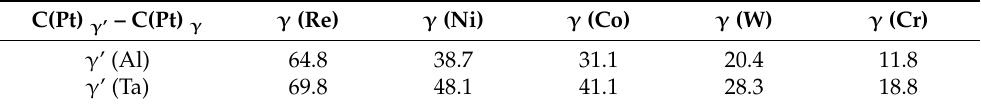
Table 3. The concentration difference (at %) when ∆ a (Pt) γ - γ ’ = 0 at 1150 ◦ C. C(Pt) γ ’ – C(Pt) γ